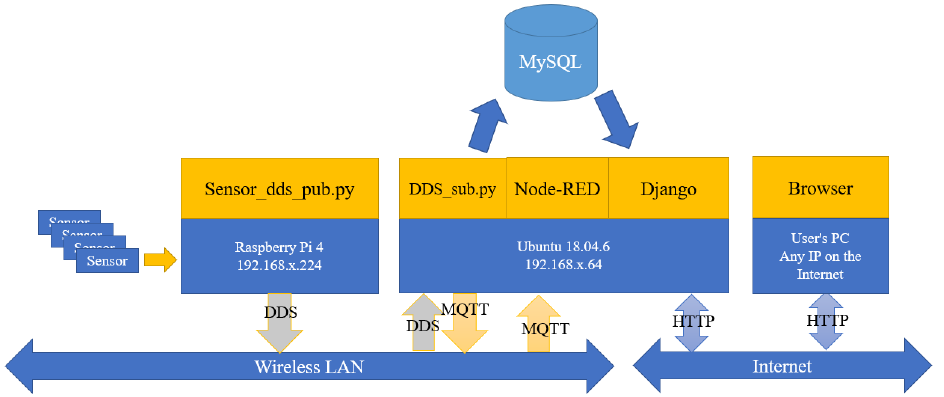
Figure 7. Data flow and main components of the implemented system.